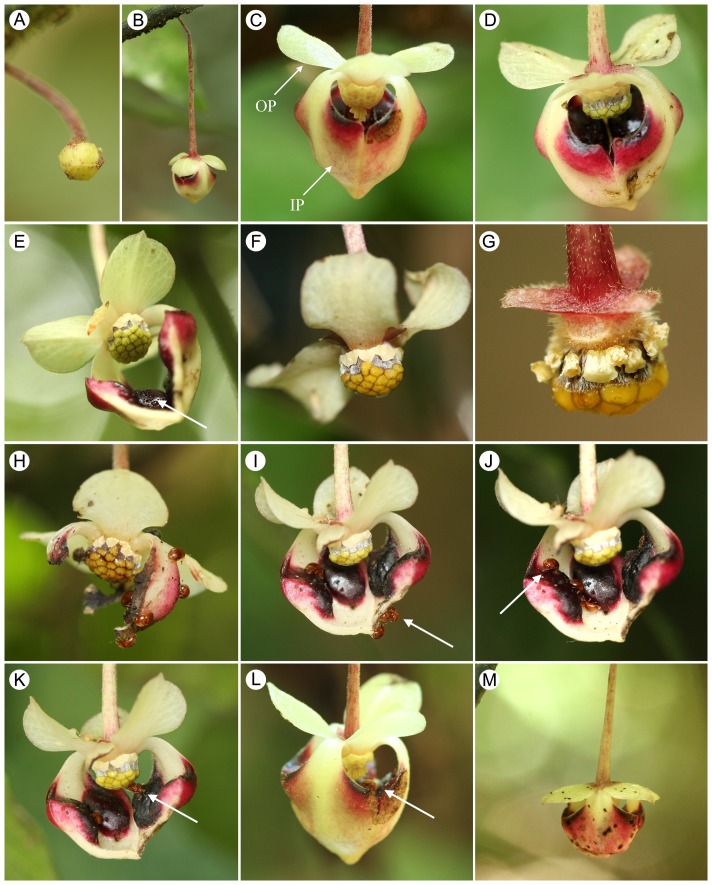
Flowers of Pseuduvaria mulgraveana, showing different phenological stages (A–G) and activities of the effective beetle pollinator, Aethina australis (H–M).(A) Early bud phase. (B) Outer petal opening phase. (C) Sexually mature staminate flower, with innermost anthers dehiscing (OP  =  outer petal; IP  =  inner petal). (D) Hermaphroditic flower in pistillate phase. (E) Hermaphroditic flower during pistillate phase, with nectar secretion (indicated by arrow) on the dark red glands. (F) Hermaphroditic flower in petal abscission phase. (G) Hermaphroditic flower in staminate phase, with anthers dehiscing. (H) Beetles consuming petals and nectar in a pistillate-phase hermaphroditic flower. (I) Beetles copulating (indicated by arrow) outside the floral chamber of a pistillate-phase hermaphroditic flower. (J) Beetles remaining on the inner petal glands of a pistillate-phase hermaphroditic flower (indicated by arrow). (K) Beetles touching stigmas of a pistillate-phase hermaphroditic flower (indicated by arrow). (L) Beetles (indicated by arrow) visiting sexually mature staminate flowers. (M) Beetle bite marks on the petals.